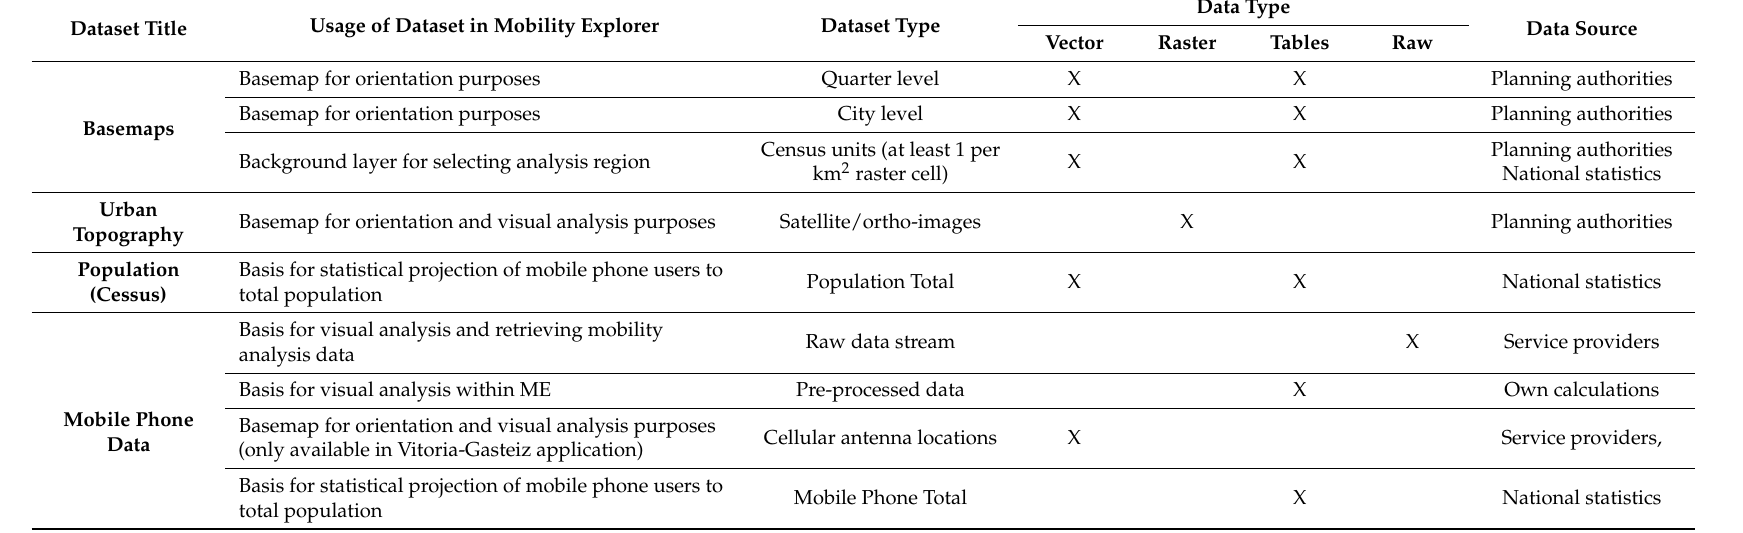
Table 3. Datasets used within the Mobility Explorer (ME)